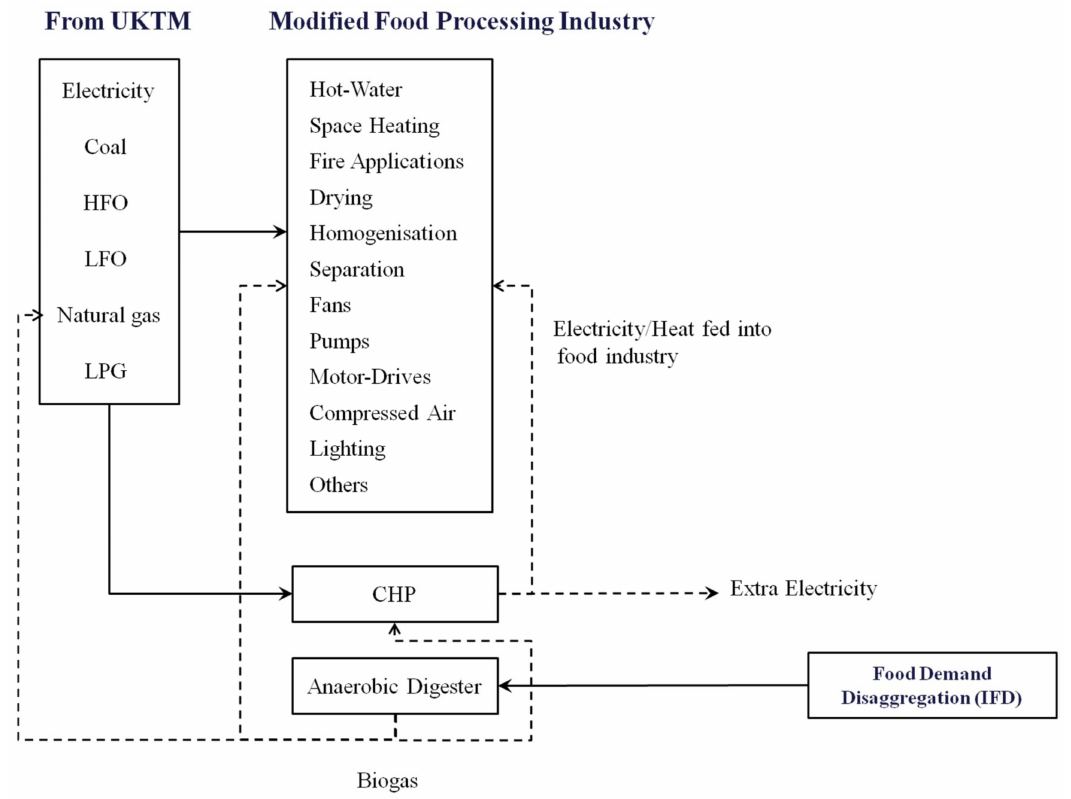
Figure 2. Schematic of UKTM Modified Food Processing